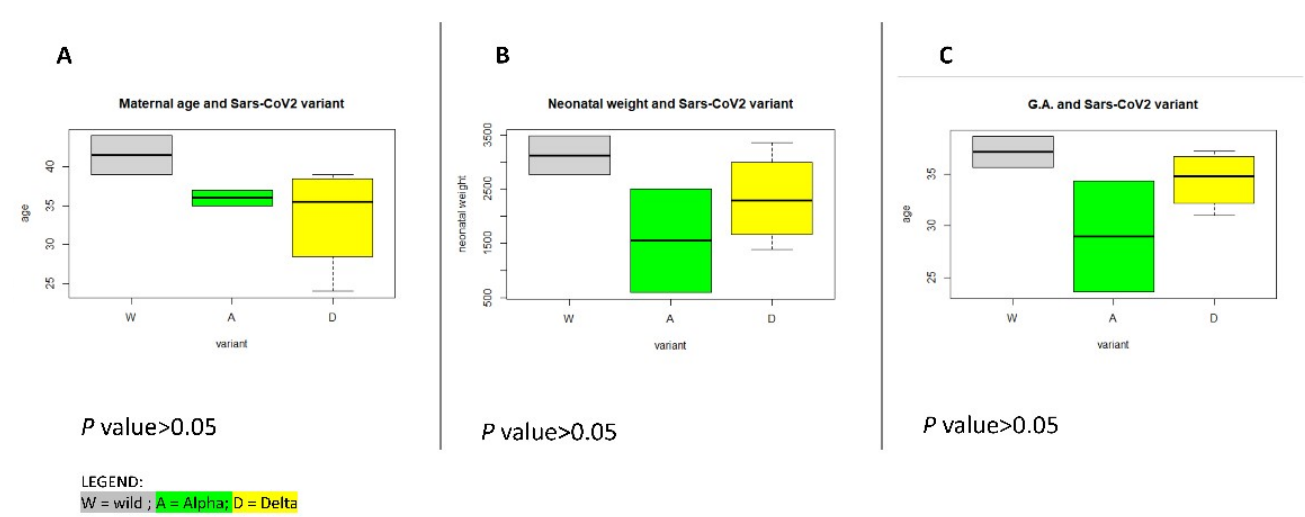
Figure 2. From left to right ( A – C ), the different characteristics of severe-critical COVID-19 affected pregnant women based on the variant (W = wild in grey, A = alpha in green, D = delta in yellow). From left to right: the maternal age, the gestational age (g.a.) and the neonatal weight. The median maternal age and the median gestational age (g.a.) were higher in the wild group, respectively 41.5 [2.5] yrs and 37.1 [1.5] wks, ds. Notably, the A group was characterized by